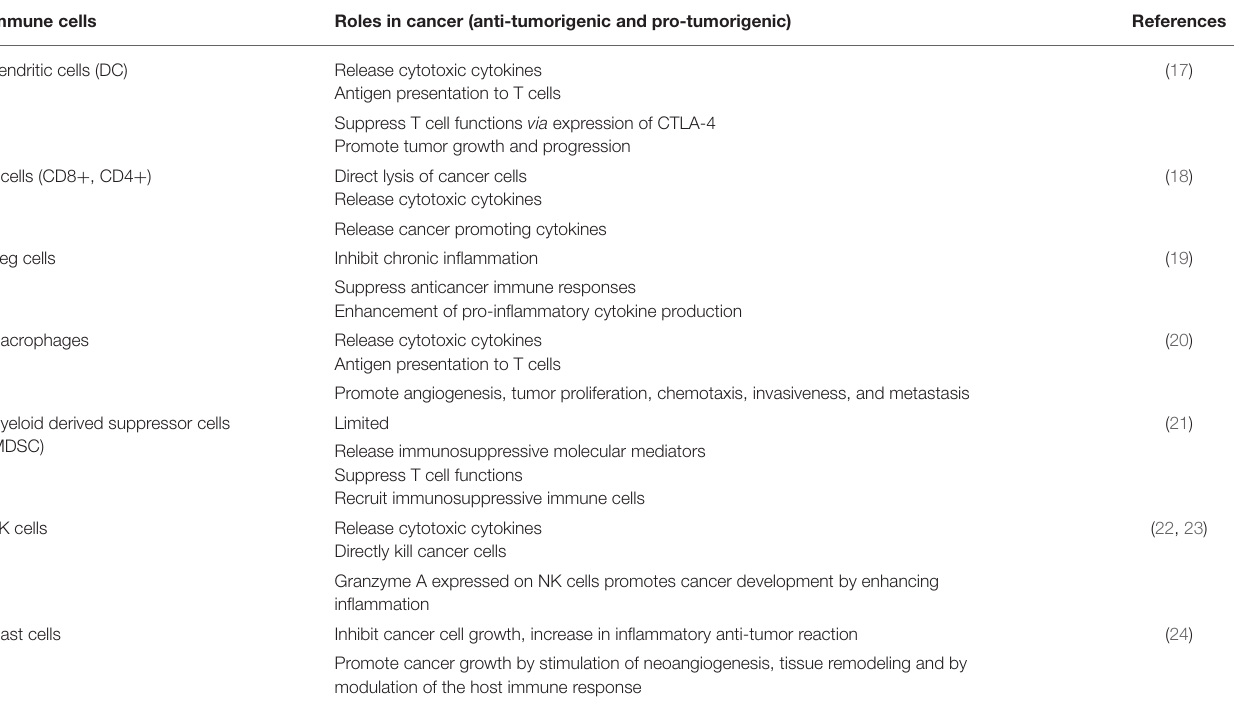
TABLE 1 | Pro-tumorigenic and anti-tumorigenic effects of immune cells. Immune cells Roles in cancer (anti-tumorigenic and